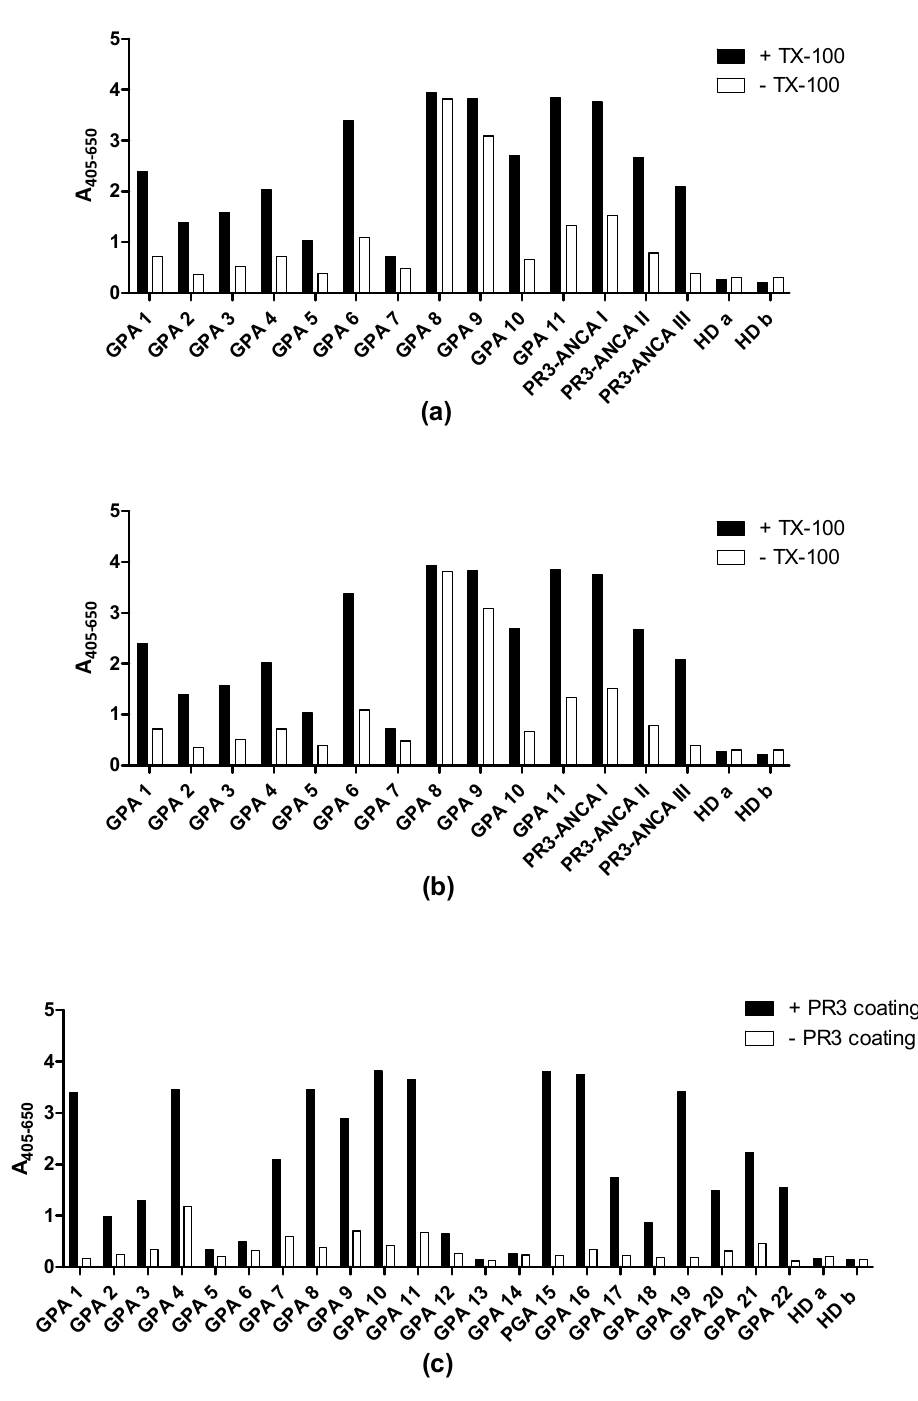
Figure 10. Reactivity of granulomatosis with polyangiitis patient sera (GPA) and healthy controls to PR3 coated in the presence or absence of 0.01% Triton X-100 analysed by ELISA. ( a ) SSI PR3. ( b ) Arotec PR3. ( c ) SSI PR3 without 0.01% Triton X-100 (TX-100).